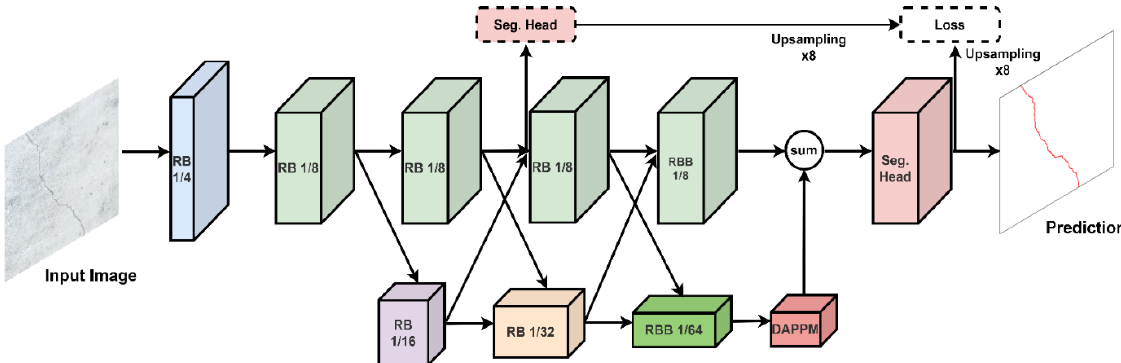
Figure 6. Overall architecture of DDRNet-23-Slim.